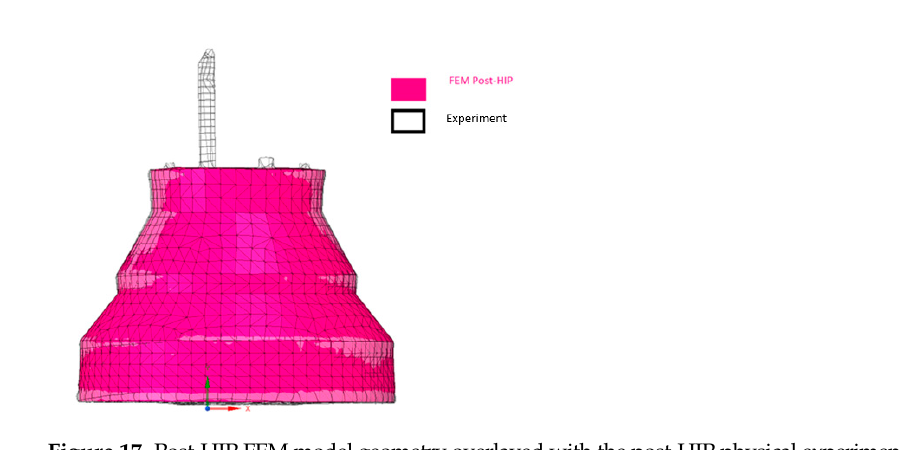
Figure 16. Pre ‐ HIP and post ‐ HIP geometries: ( a ) experiment; ( b ) FEM.